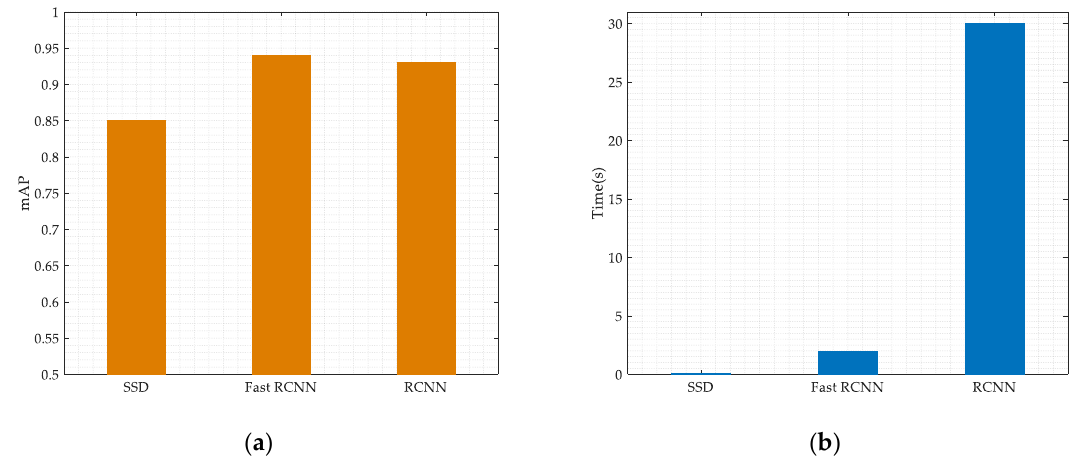
Figure 12. Different networks performances. ( a ) performances for mAP; ( b ) performances for time.